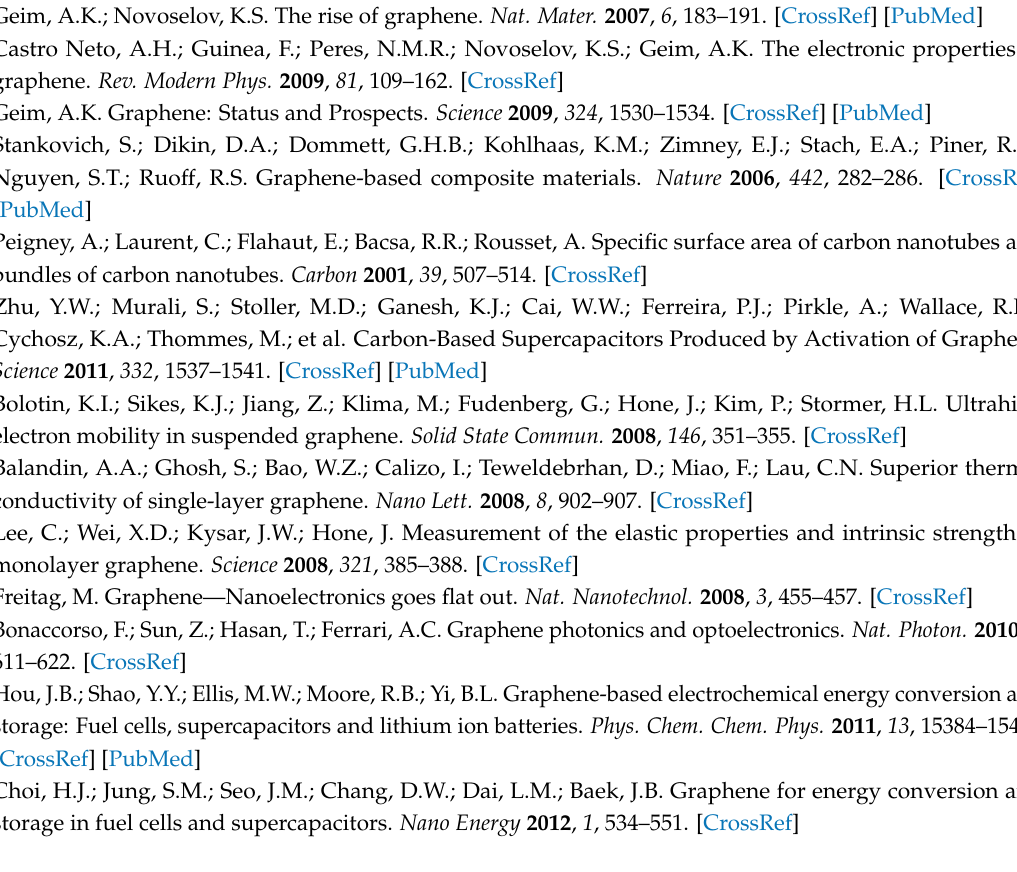
Figure S1: Calculated band structures of the ( a ) pristine graphene and ( b ) graphene with